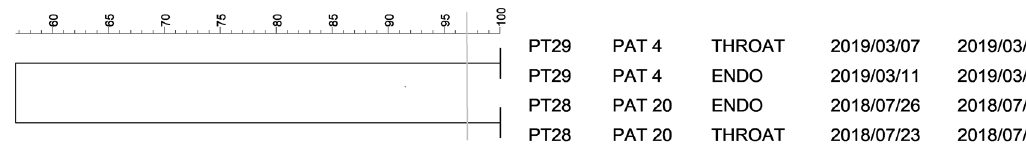
Figure 5. Dendrogram for restriction patterns of E. hermannii isolates. Legend: horizontal axis—similarity of isolates (%); vertical axis—pulsotype, patient code, type of sample, date of sample collection, date of VAP diagnosis; PT pulsotype, PAT patient, ENDO endotracheal aspirate sample, THROAT throat swab. The vertical line indicates the similarity threshold set at